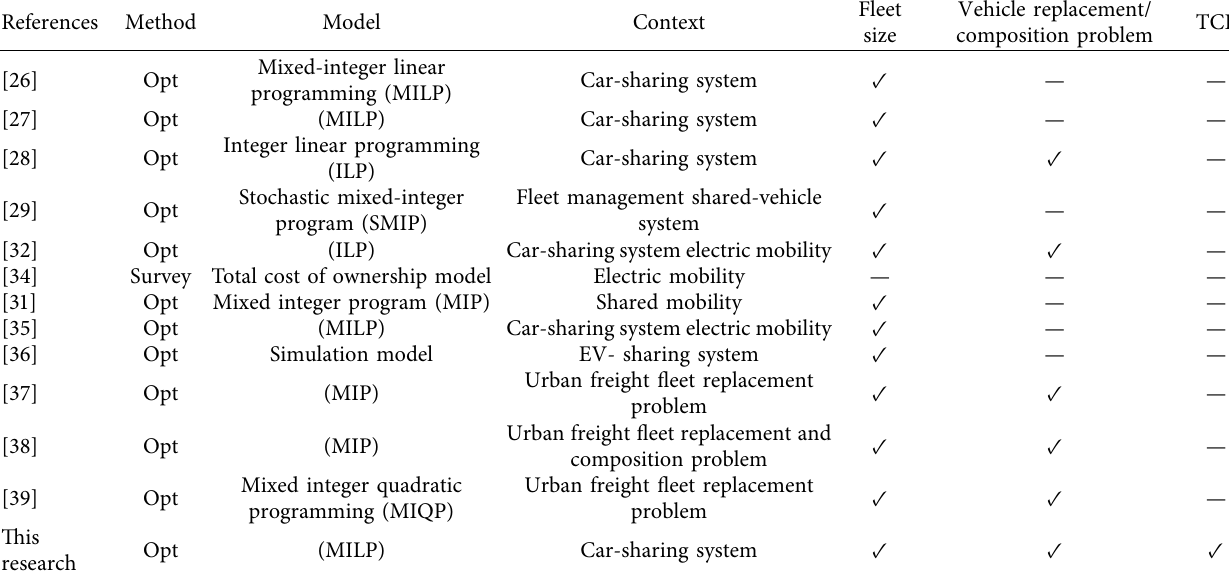
Table 2: Summary of characteristics of previous